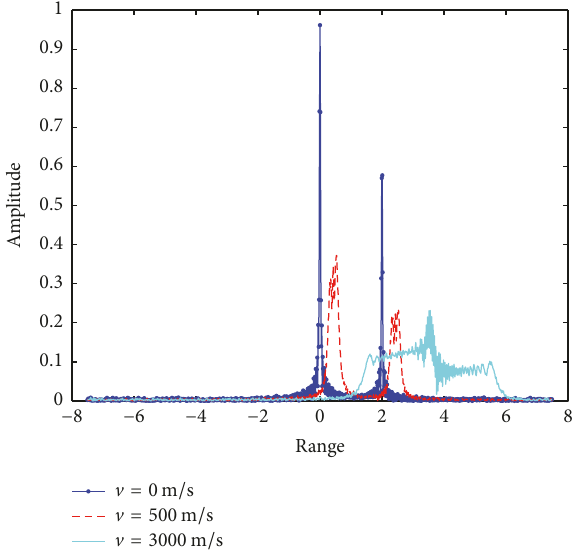
Figure 2: The flow of multiple subband coherent